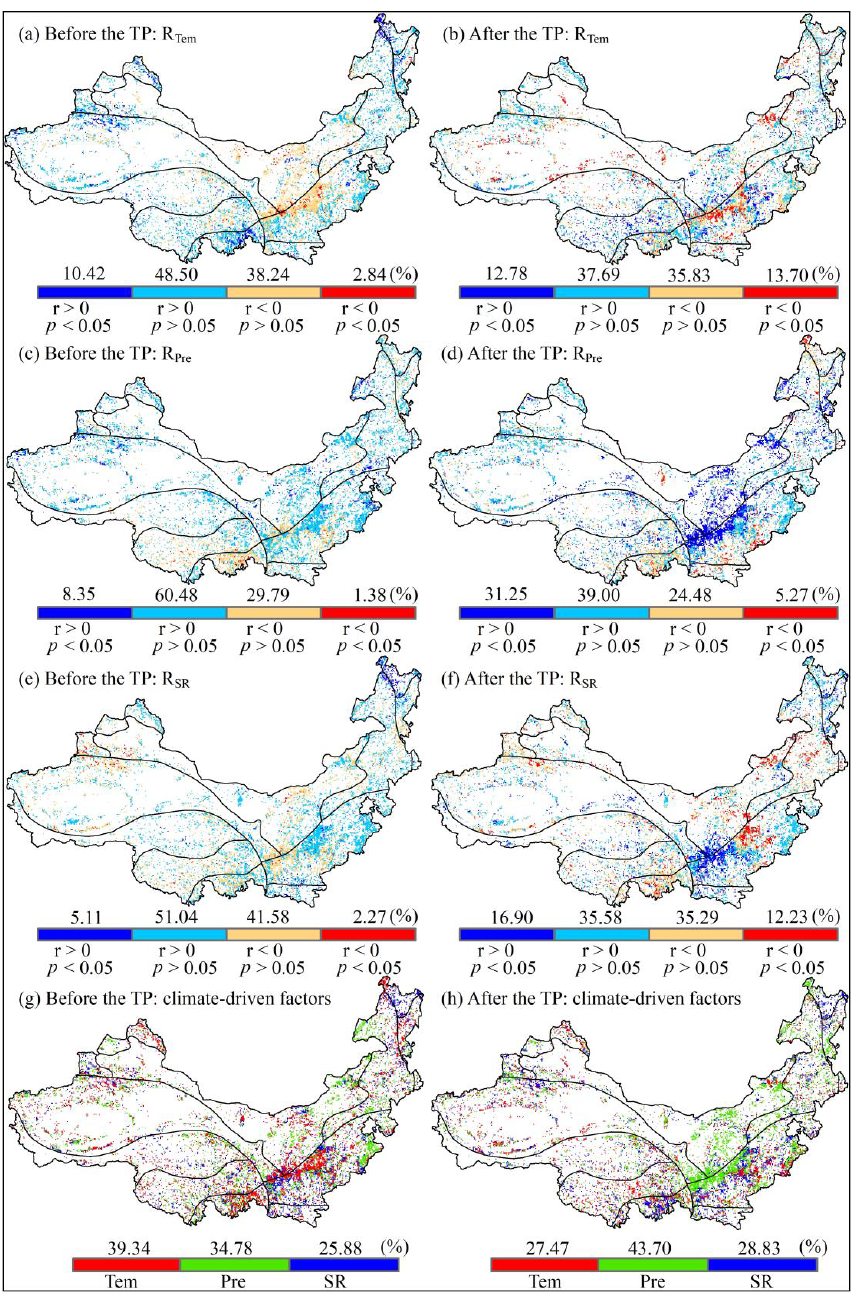
Figure 7. Before and after the turning point, the significance of PCC between NDVI and temperature ( a , b ), precipitation ( c , d ) and solar radiation ( e , f ) and the spatial distribution pattern of climate control factor ( g , h ) in the growing season. Tem, Pre, SR represent temperature, precipitation, and solar radiation, respectively. Before and after the TP, the correlation between GSN and the three climate factors had changed significantly (Figure 7a – f). According to the square value of R Tem , R Pre and